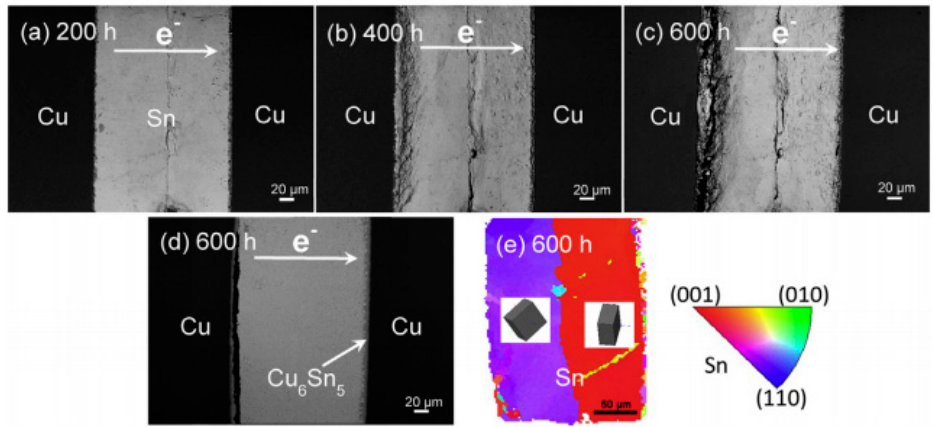
Figure 6. Cross-sectional microstructures of the interconnections after EM for ( a ) 200 h, ( b ) 400 h, ( c ) 600 h, ( d ) 600 h (polished), and ( e ) EBSD inverse pole figure orientation image map Reprinted with permission from Ref. [48] Copyright 2016 Elsevier.